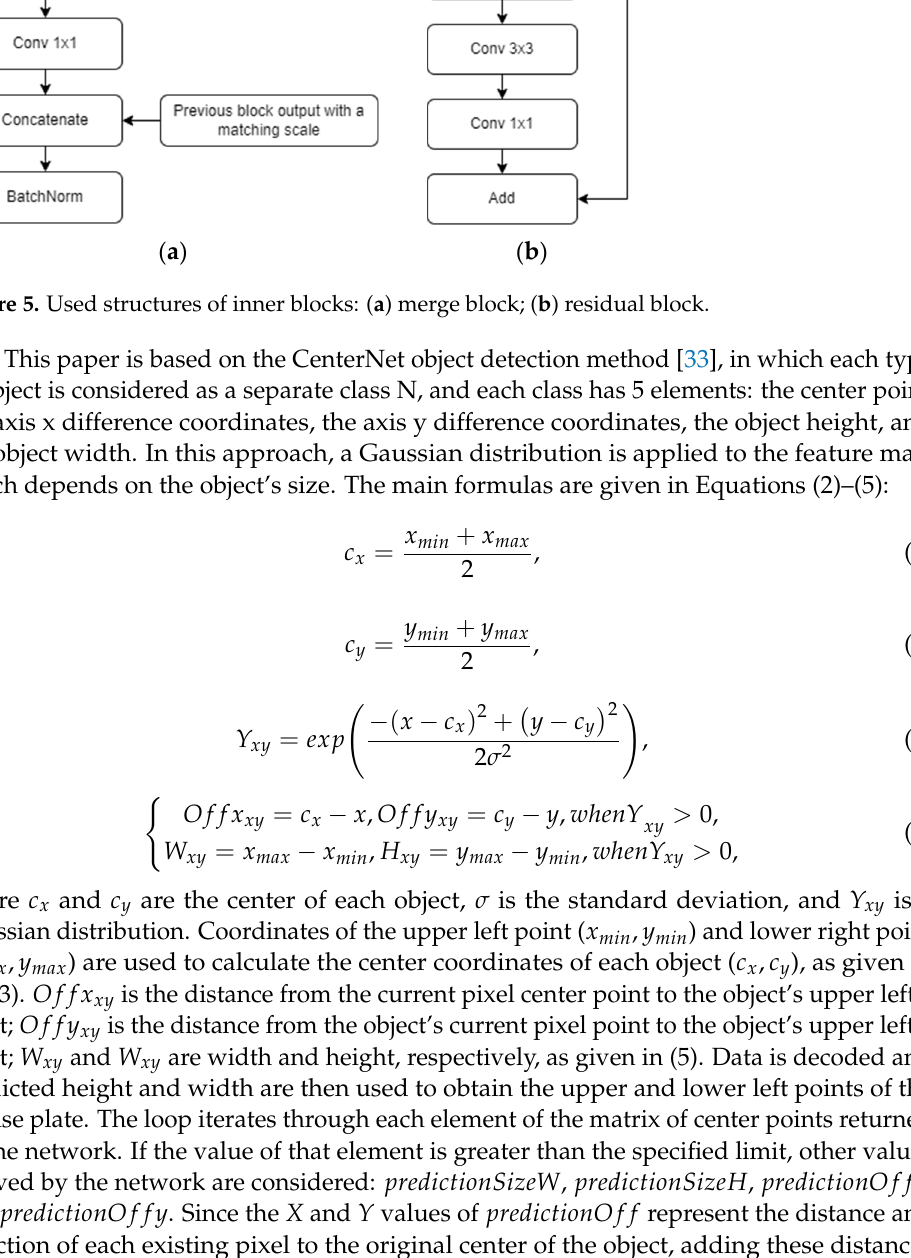
Figure 4. CNN structure for license plate number detection. The structure is identical, but the input and output differ: ( a ) structure of the first network for preliminary number detection; ( b ) structure of the second network for precise number detection.